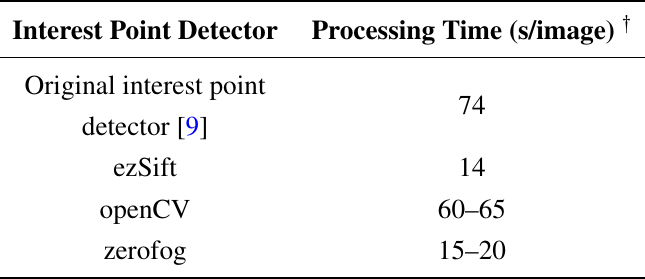
Table 1. Processing time of interest point